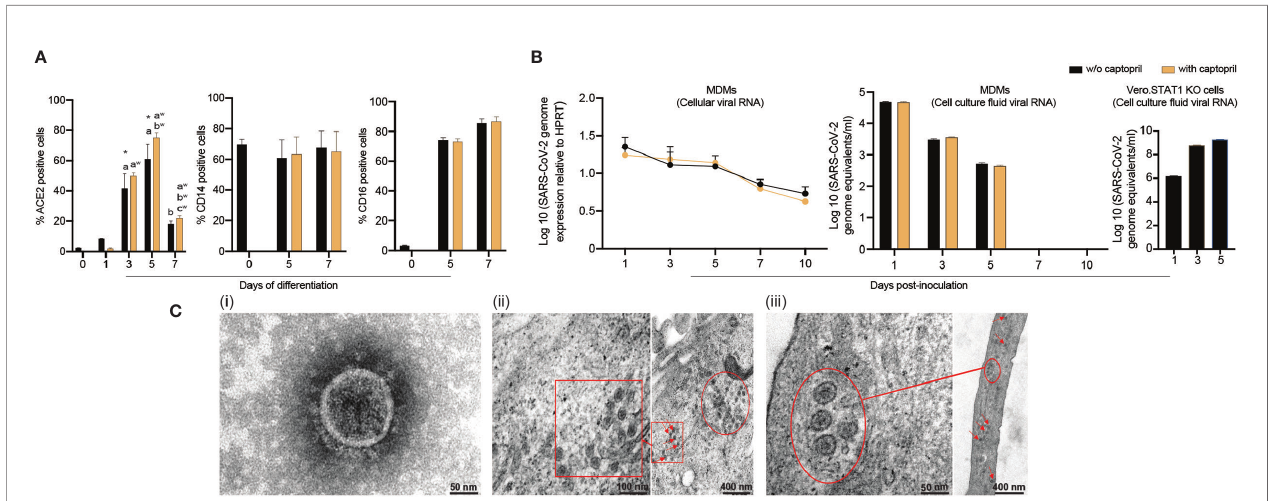
FIGURE 1 | SARS-CoV-2 restrictive infection of human MDMs. (A) Expression of SARS-CoV-2 cell entry receptor ACE2 and phenotypic surface markers CD14 and CD16, during differentiation of monocytes into macrophages, was analyzed by fl ow cytometry in absence or presence of captopril. (B) SARS-CoV-2 presence in MDMs. SARS-CoV-2 (MOI=0.01) was used to infect MDMs (with or without captopril). The number of virus genome equivalents per ml was measured in cell lysates and culture supernatants by RT-qPCR. Vero.STAT1 KO cells served as a positive control. (C) Transmission electron micrographs of SARS-CoV-2-challenged MDMs. ( C .i) A viral particle from a pool of SARS-CoV-2 used for the virus challenges. SARS-CoV-2-challenged MDMs [( C. ii) day 5, and ( C. iii) day 14 after viral exposure]. Red arrows, circles, and boxes demonstrate clusters of viral particles within the virus-challenged macrophages. All experiments were done at least twice with representative images depicted here. (A, B) Data are represented as mean ± SEM (n=3-6 donors). Statistical signi fi cance between groups was determined using one-way ANOVA, and p < 0.05 was considered signi fi cant (*signi fi cantly different from day 0 w/o captopril, a: signi fi cantly different from day 1 w/o captopril,